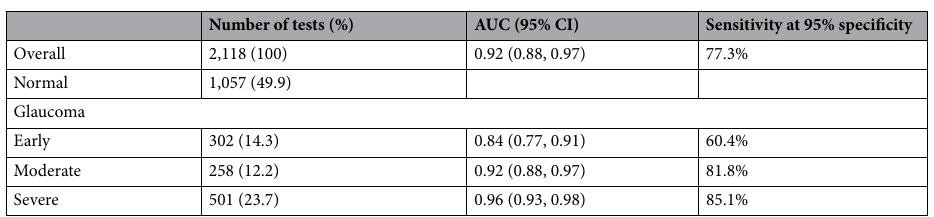
Table 3. Area under the receiver operating characteristic curve (AUC) and sensitivity at 95% specificity for different levels of disease severity, according to the Hodapp–Parrish–Anderson classification of glaucoma severity, based on visual field damage. AUC area under the receiver operating characteristic curve, CI confidence interval.